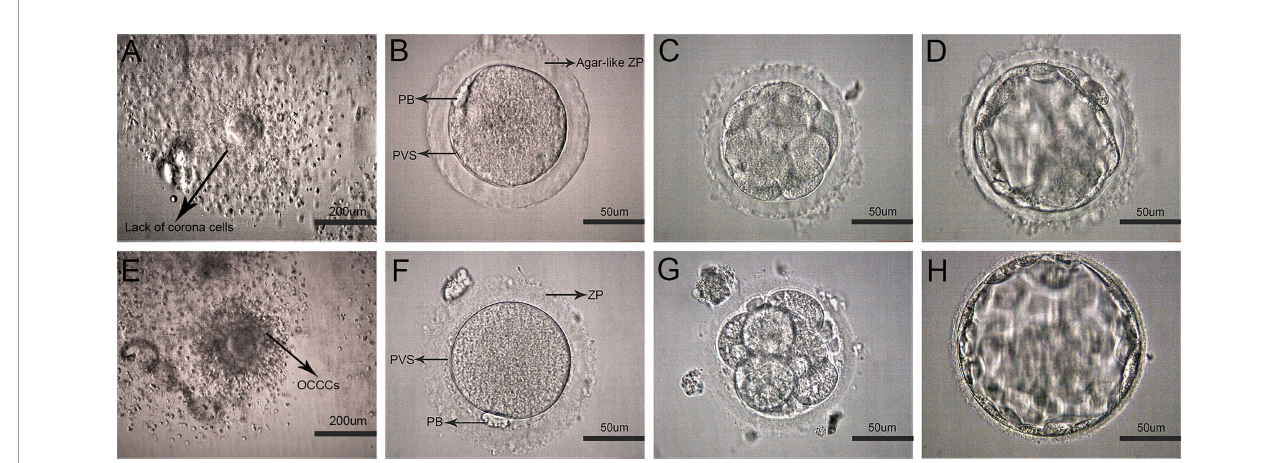
FIGURE 1 | Representative images of early development on human oocytes with agar-like and normal ZP. (A) Oocyte corona cumulus complexes (OCCCs) with agar-like ZP (Arrow displayed no obvious corona). (E) Normal OCCCs (Arrow displayed clear corona). (B) Human mature metaphase II oocyte (MII) with agar-like ZP. (C , D) Cleavage embryo (D3) and blastocyst(D5) with agar-like ZP. (F) MII oocyte with normal ZP. (G, H) Cleavage embryo (D3) and blastocyst (D5) with normal ZP.